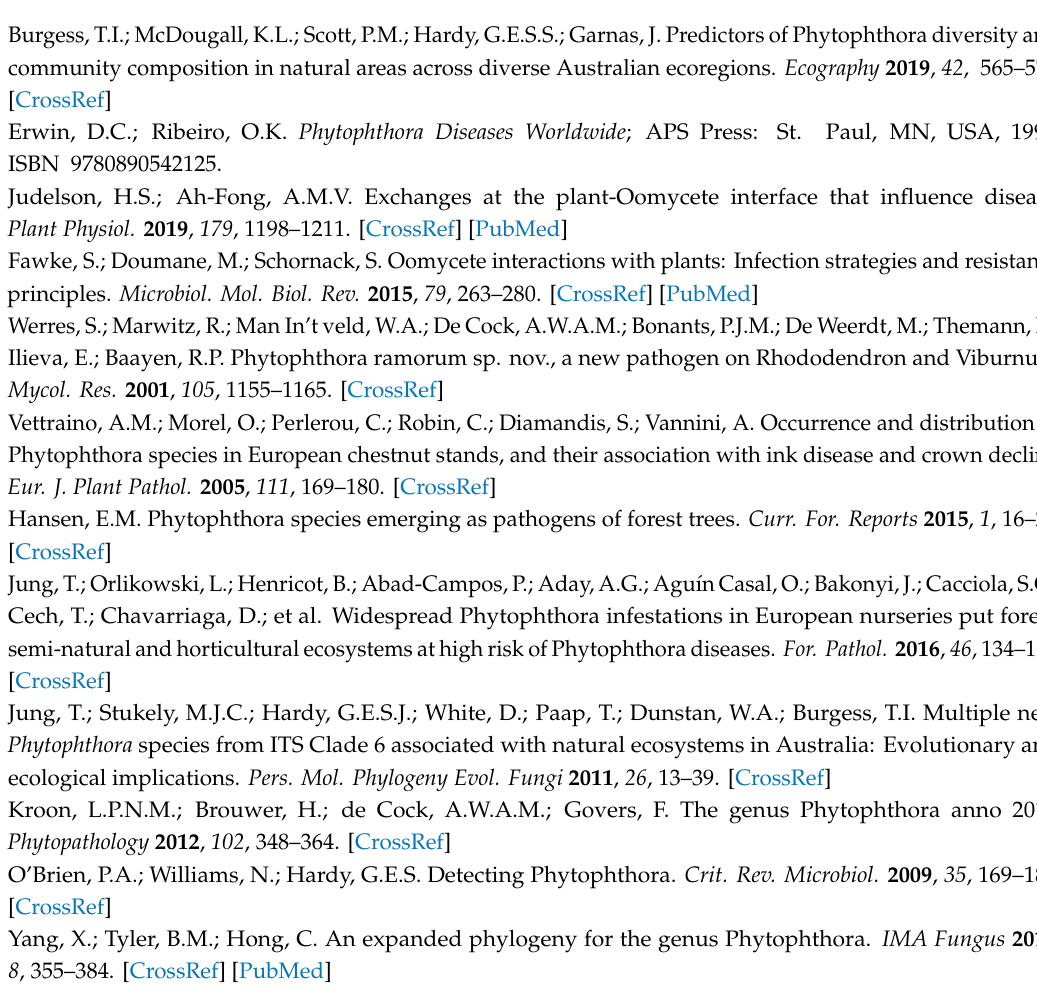
s1. Table S1: Mycelium proteome of Phytophthora species. Supplementary tables to Figure 1; Table S2: The most significant species-specific features. Supplementary tables to Figure 2; Tables S3–S5: P. palmivora proteins detected in planta, barley metabolites and proteins identified in response to P. palmivora . Supplementary tables to Figure 3; Tables S6–S9: Mycelium proteome of P. infestans and P. infestans proteins identified in planta. Supplementary tables to Figure 4, 6–8; Tables S10 and S11: Results of in silico proteome digest and protein correlation with P. infestans DNA in planta. Supplementary tables to Figure 7; Table S12: Identified P. infestans proteins in all experiments. Supplementary table to Figure 9; Tables S13 and S14: Complete list of isolates and parameters of qPCR analysis. Supplementary tables to Materials and